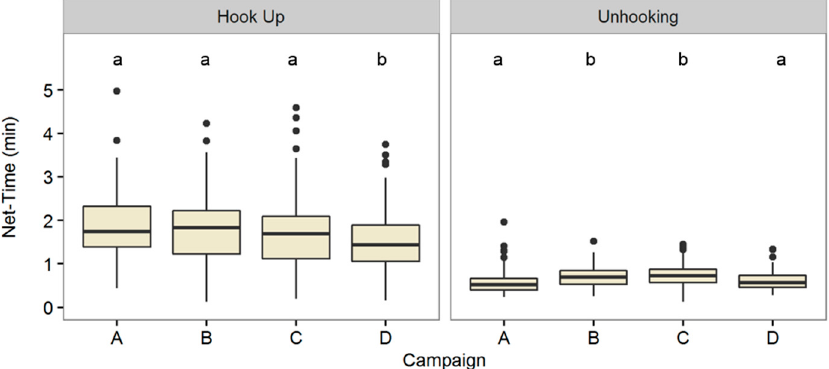
Figure 6. Variability of Hook Up and Unhooking net-time (min) across the four field campaigns. The box contains 50% of all data and is bordered by the upper and lower quartile. The crossline within the box indicates the median. The whiskers cover the 1.5 interquartile range and the solid dots outliers above. Different lower case letters indicate significant differences between campaign means (Kruskal-Wallis and post-hoc pairwise comparison Nemenyi-test with χ 2 -approximation, p < 0.05).